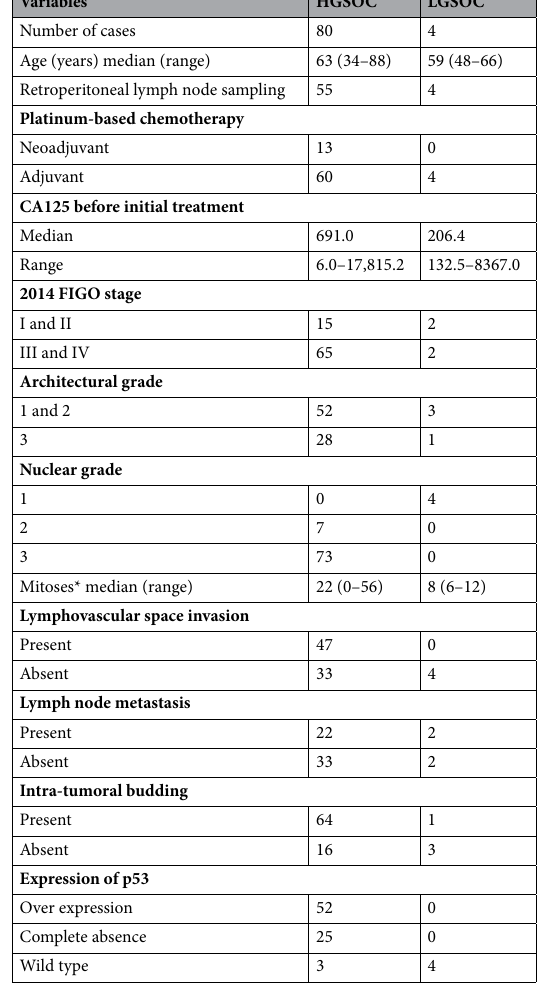
Table 1. Clinicopathologic characteristics of 84 serous ovarian carcinomas. HGSOC high-grade serous ovarian caricinoma, L GSOC low-grade serous ovarian carcinoma. *X 10 high power